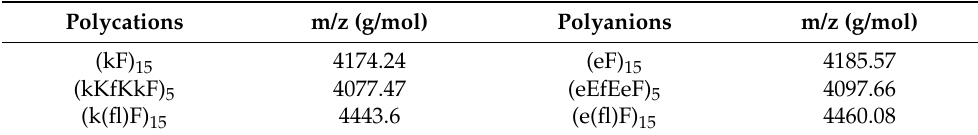
Table 1. Sequence pairs of phenylalanine peptides with their measured mass-to-charge ratio, using MALDI-TOF mass spectroscopy. K and E refer to lysine and glutamic acid, respectively. F refers to phenylalanine and (fl)F represents 4-fluoro-phenylalanine. Lower and upper cases are representative of D and L chirality, respectively. All sequences have a degree of polymerization of